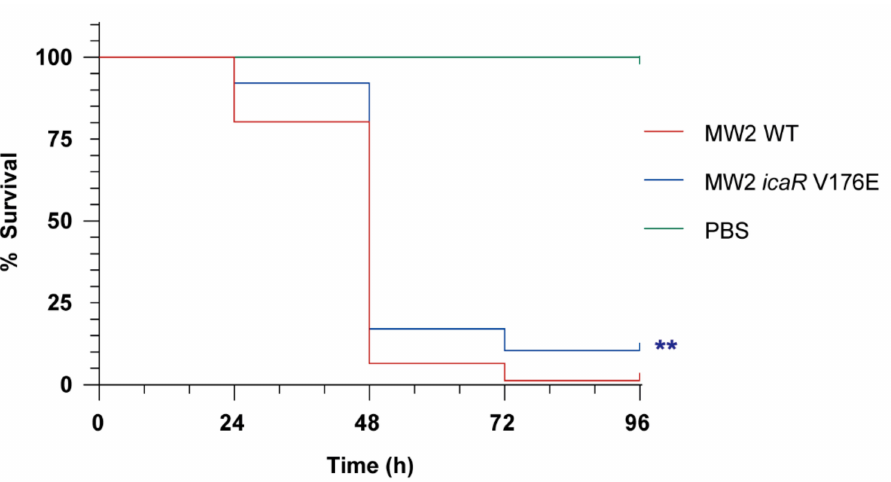
Figure 6. Galleria mellonella infection with S. aureus MW2 wild type and MW2 icaR V176E mutant strains. Groups of larvae (25/group) were inoculated with 10 µ L PBS (uninfected control group) or bacterial suspensions containing 10 7 CFU of the corresponding strain, into the last proleg and incubated at 37 ◦ C. Worms were checked daily, and any deaths were recorded every 24 h, for a total of four days. Three independent experimental trials were performed. Survival data were plotted using the Kaplan-Meier method and expressed as a percentage of survival versus time. Statistically significant differences were determined using the log rank test (**, p <